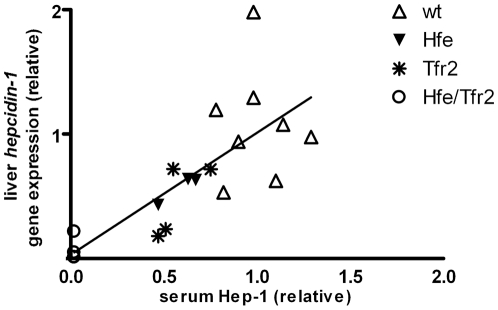
Correlation between serum Hep-1 and liver hepcidin-1 mRNA.Data are obtained from wild type mice (n = 8), Hfe knockout mice (n = 3), TfR2 Y245X mice and double affected Hfe/TfR2 Y245X mice (n = 4). Real time values are expressed as mRNA content relative to the mean value obtained for the wild-type mice. Likewise serum Hep-1 values are expressed relative to the mean value from the wild type mice. r (Spearman) = 0.8263, P<0.001.